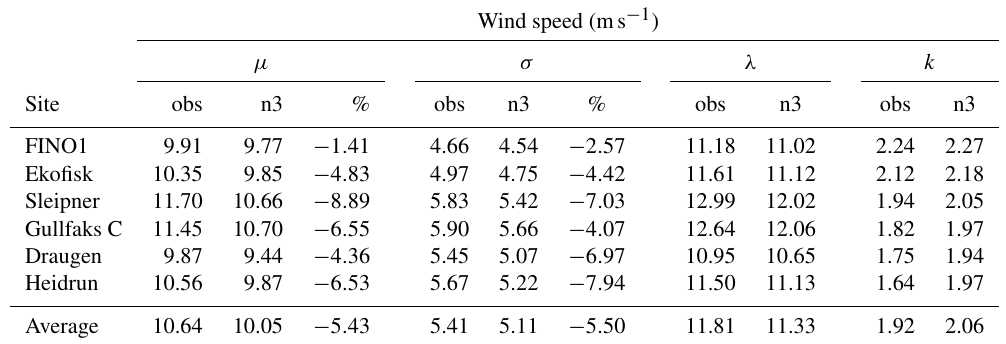
Table 5. Statistical measures of the wind speed (ms − 1 ) for the observations (obs) and the model (n3). µ and σ are the arithmetic mean and standard deviation, respectively. λ and k are the Weibull scale and shape parameters, respectively. The wind speed validation is performed at the sensor height to avoid uncertainties related to power law extrapolation (see Table 1 for information on heights).